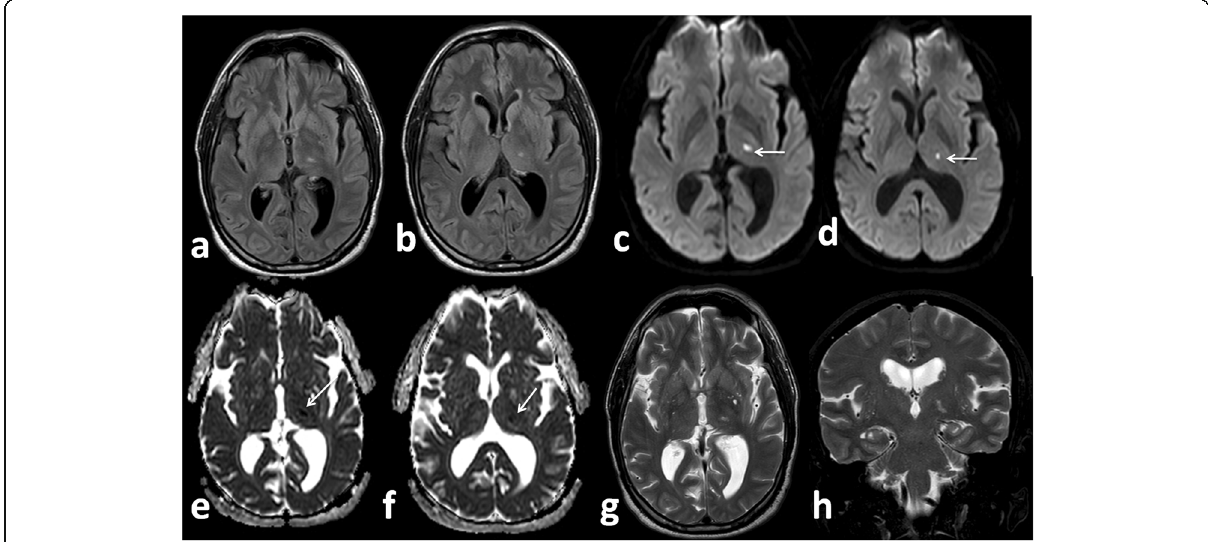
Fig. 10 Male patient 48 years old presented with sensory loss. Left thalamic infarction. DWI (white arrow in c and d ), ADC map (white arrows in e and f